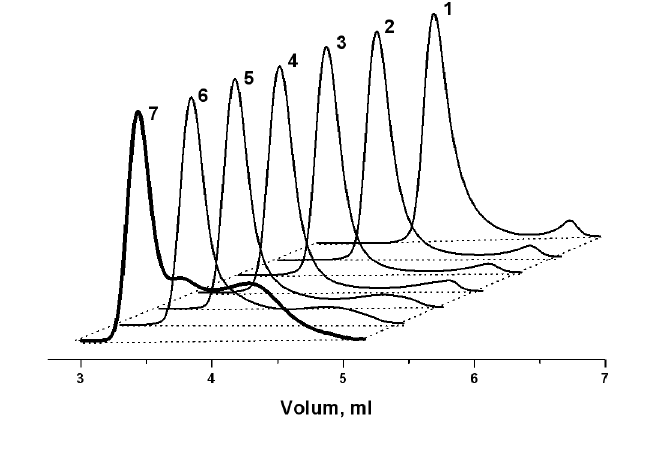
Fig. 5 The SEC-traces of the PB samples (the refractometric detector). Heptane as solvent, DLP as initiator. [M] 0 = 2.05 mol/l, [I] 0 = 0.13 mol/l, 30¸C. The conversions: 0.11 (1); 0.22 (2); 0.32 (3); 0.45 (4); 0.62 (5); 0.73 (6); 0.83